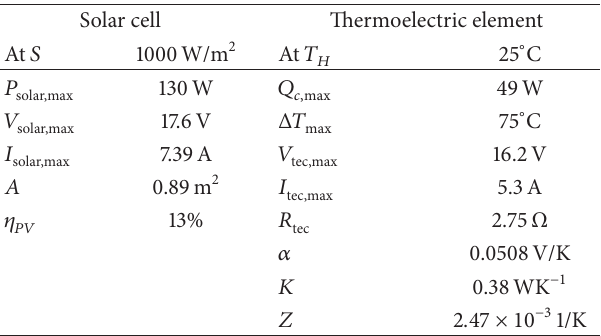
Table 1: Specifications of solar thermoelectric chiller. Solar